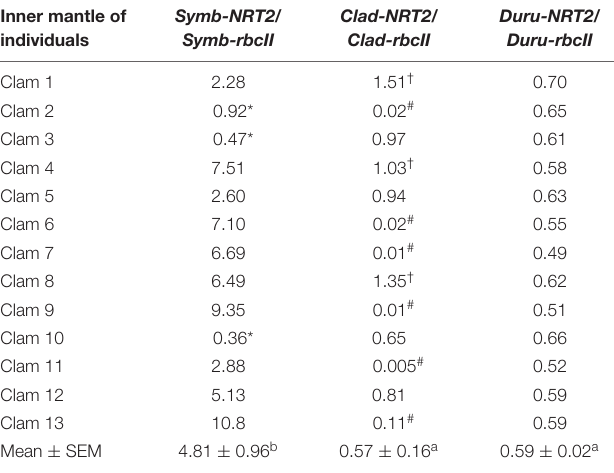
TABLE 5 | Ratios of the transcript levels of nitrate transporter 2 ( NRT2 ) to that of form II ribulose-1,5-bisphosphate carboxylase/oxygenase (rbcII) from Symbiodinium (Symb-NRT2/Symb-rbcII), Cladocopium (Clad-NRT2/Clad-rbcII), and Durusdinium (Duru-NRT2/Duru-rbcII) obtained from the inner mantle of Tridacna squamosa ( n =